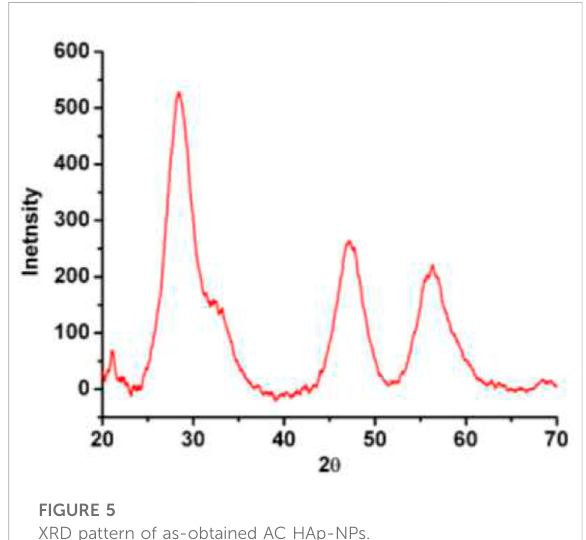
FIGURE 5 XRD pattern of as-obtained AC HAp-NPs.